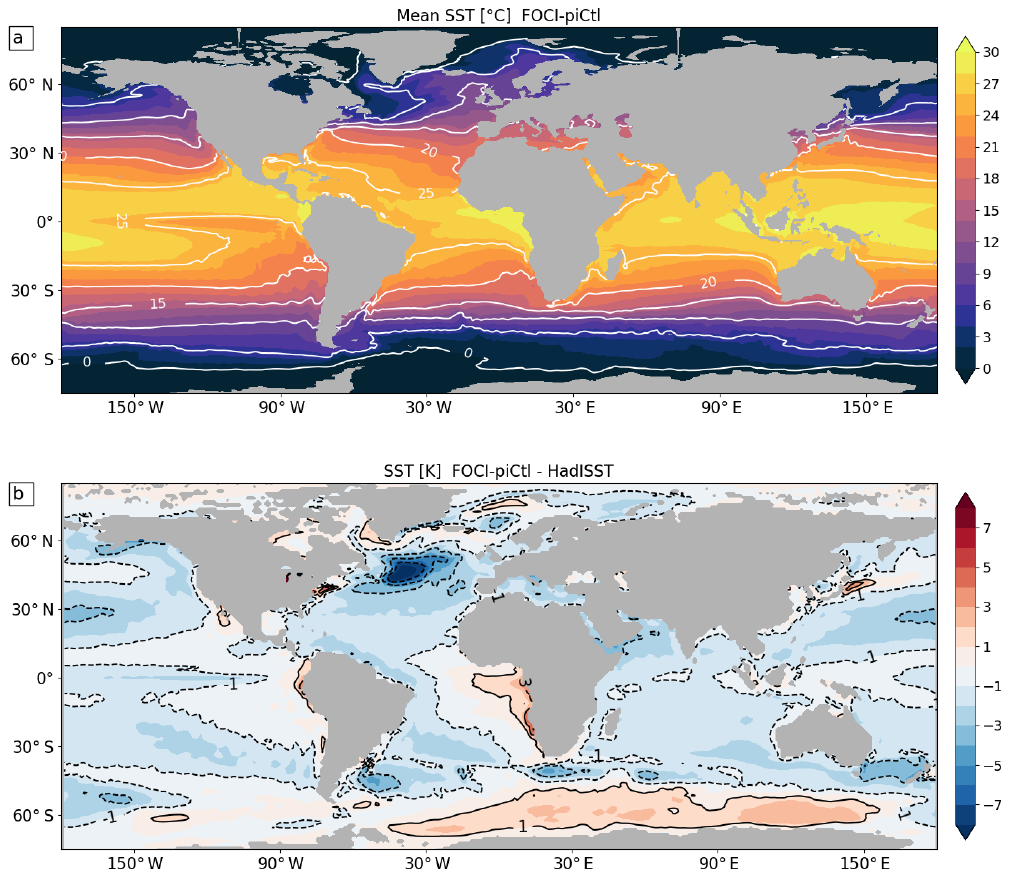
Figure 13. (a) Mean SST in ◦ C of the FOCI-piCtl reference simulation averaged over the last 500 years; (b) FOCI-piCtl SST bias (in Kelvin) with respect to the observed Hadley Centre Sea Ice and Sea Surface Temperature dataset (HadISST)